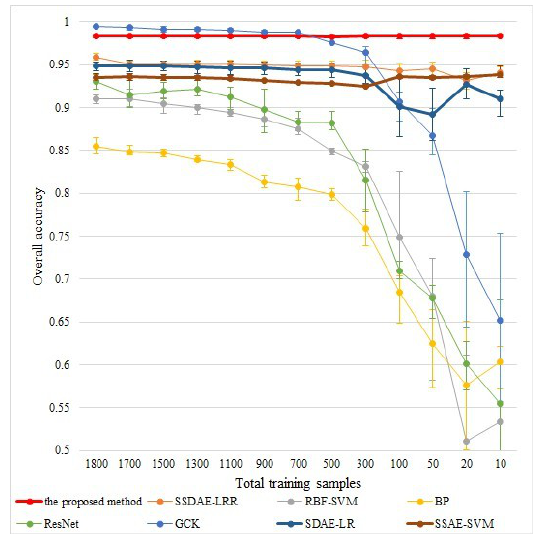
Figure 12. OA curves for different methods in the classification of the Pavia University dataset with different numbers of labelled samples.